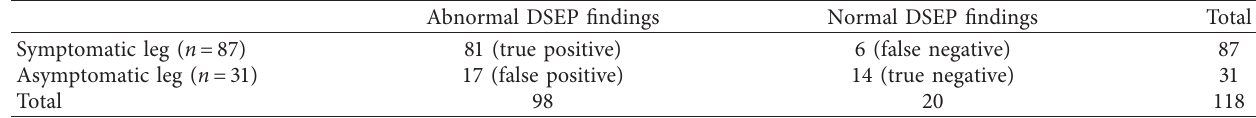
Table 2: Distribution of DSEP results according to radiculopathy symptoms.